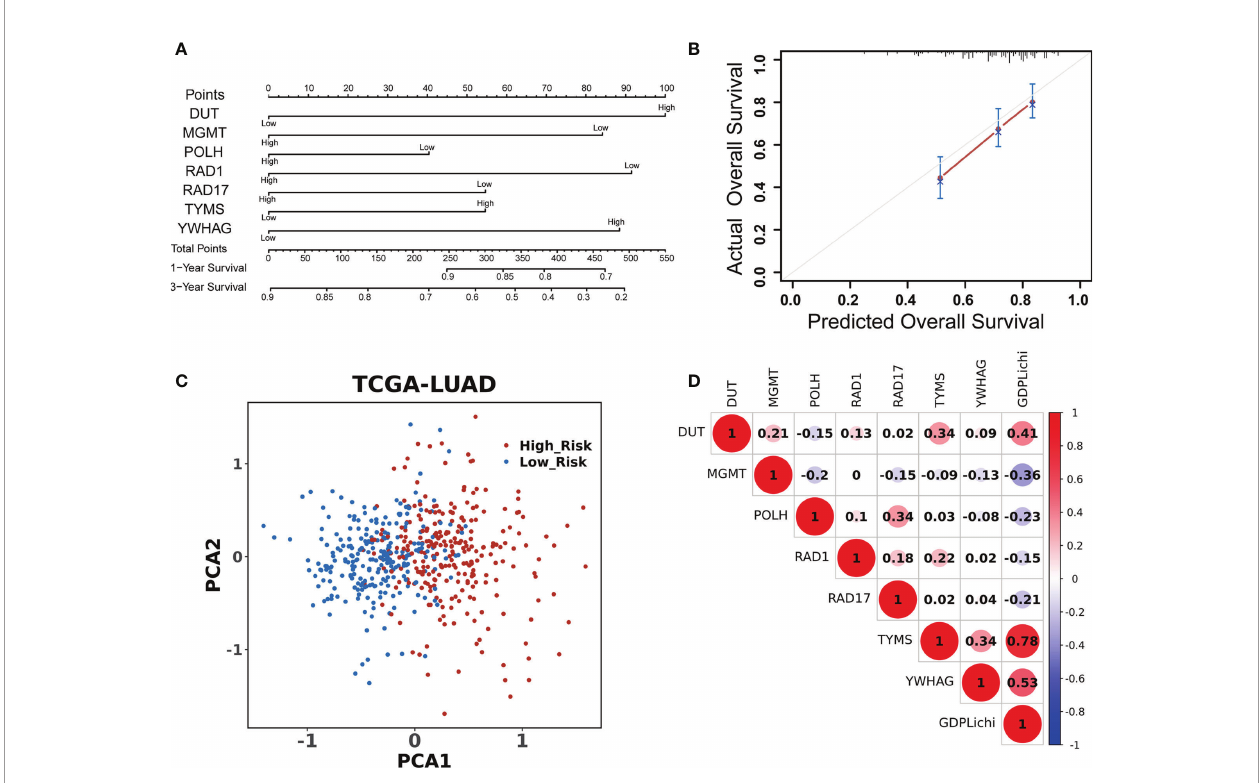
FIGURE 2 | DDR signature accurately predicts the prognosis of LUAD patients. (A) Univariate and multivariate Cox regression analyses screened out seven risk genes. The point number represents a score for the relation between the expression of each selected gene and the predicted survival calculated by Cox regression. High and low represent the highest and lowest expression levels of the gene, respectively. Total points were the sum of the individual points from the seven selected genes. Based on the total points, 1-year and 3-year predicted overall survival rates of each LUAD patient were calculated. The higher the number, the lower the predicted survival. (B) Multivariate Cox regression analysis of the seven risk genes in predicting the survival of LUAD patients. (C) PCA based on the expression pro fi le of the seven risk genes from different risk groups. (D) Correlation between the GDPLichi and the seven risk genes in the TCGA LUAD